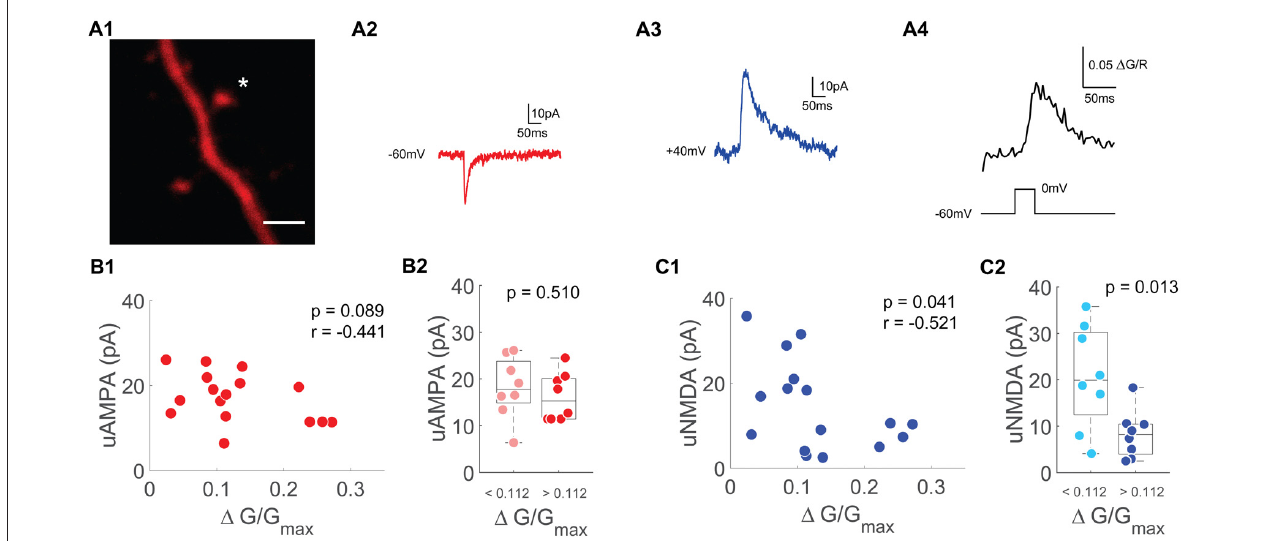
FIGURE 4 | Single spine uNMDA EPSCs are negatively correlated with depolarization induced spine Ca 2 + transients. (A1) Z-projection of the imaged spine (marked with an asterisk). Scale bar: 2 µ m. (A2) Averaged example trace of an uncaging evoked current at − 60 mV. (A3) Averaged example trace of an uncaging evoked current at +40 mV. (A4) Averaged Ca 2 + transients evoked by a depolarization step from − 60 mV to 0 mV for 30 ms. (B1) Scatter plot of depolarization step evoked Ca 2 + transients and uncaging evoked currents at − 60 mV (uAMPA). Statistics: spearman correlation. (B2) Median box plot of uAMPA-EPSC amplitudes of spines with smaller (light red) and larger (red) depolarization mediated VGCC Ca 2 + transients grouped by the median. Statistics: t -test. (C1) Scatter plot of depolarization step evoked Ca 2 + transients and uncaging evoked currents at +40 mV (uNMDA) measured 50–60 ms after onset. Statistics: spearman correlation. (C2) Median box plot of uNMDA-EPSC amplitudes of spines with smaller (light blue) and larger (blue) depolarization mediated VGCC Ca 2 + transients grouped by the median. Statistics: t -test.